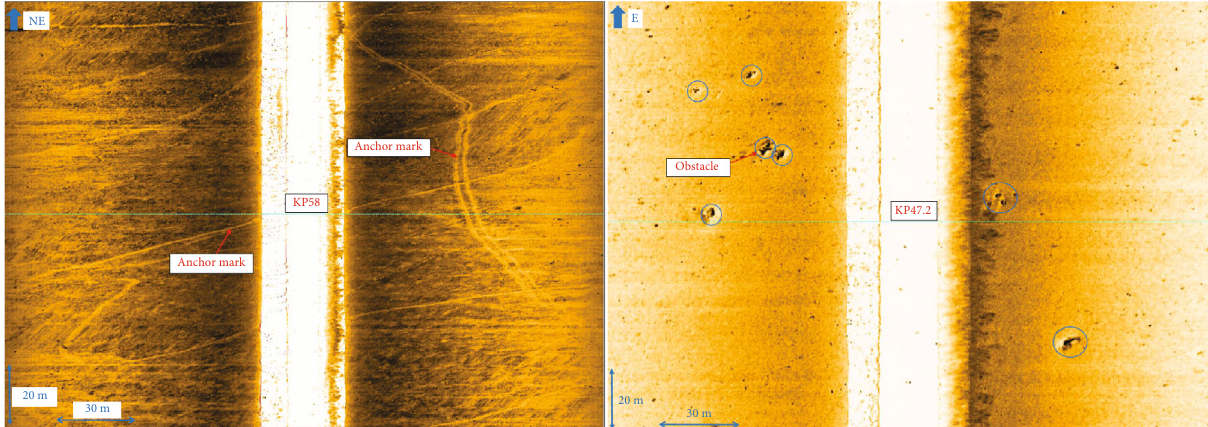
Figure 8: Side-scan sonar shows anchor marks and obstacles distributed on the seabed of the East China Sea shelf.